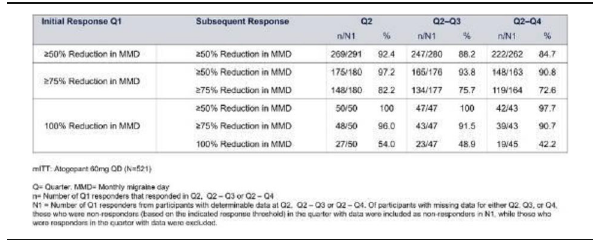
Table 2 (abstract P105). Proportion of Participants in the long-term safety trial with an Initial Response of ≥ 50%, ≥ 75% or 100% Reduction in MMD with Sustained Response through to Q4